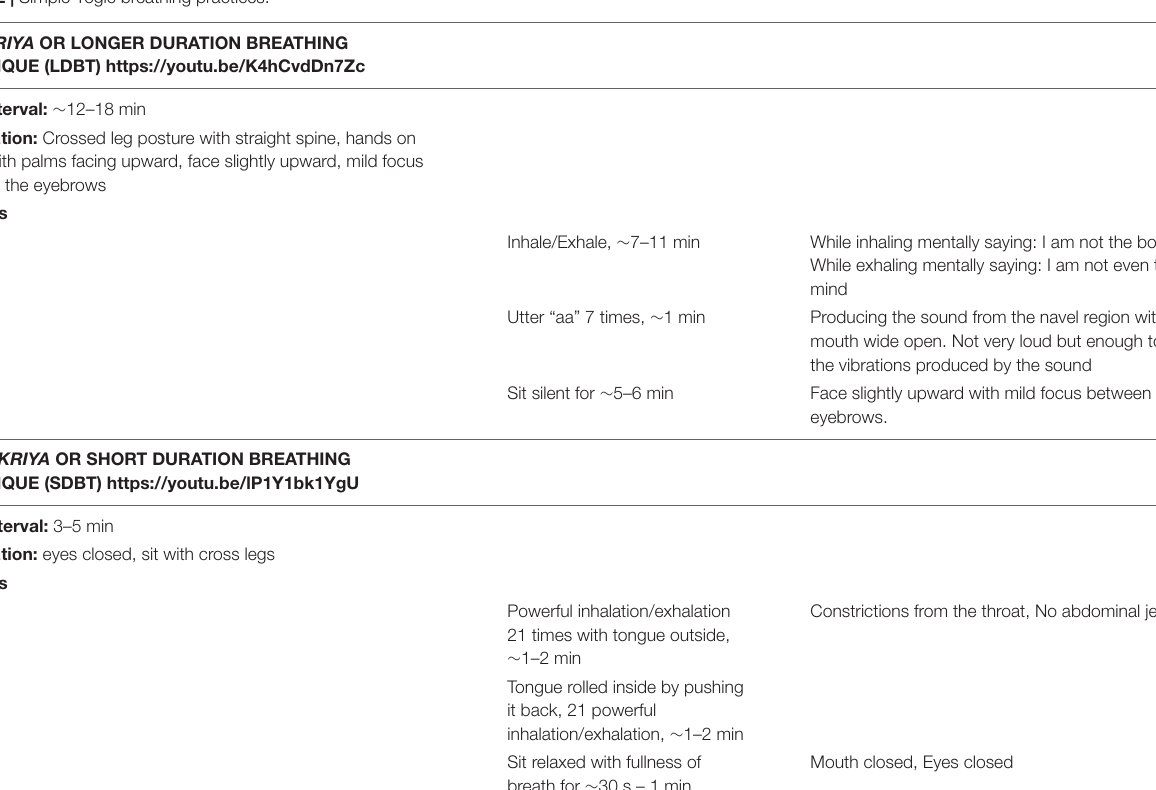
TABLE 2 | Simple Yogic breathing